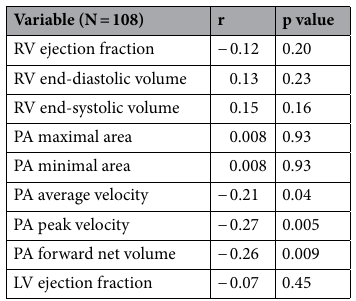
Table 2. Spearman correlation coefficients between pulmonary vascular resistance and cardiovascular magnetic resonance parameters. LV left ventricle, PA pulmonary artery, RV right ventricle.